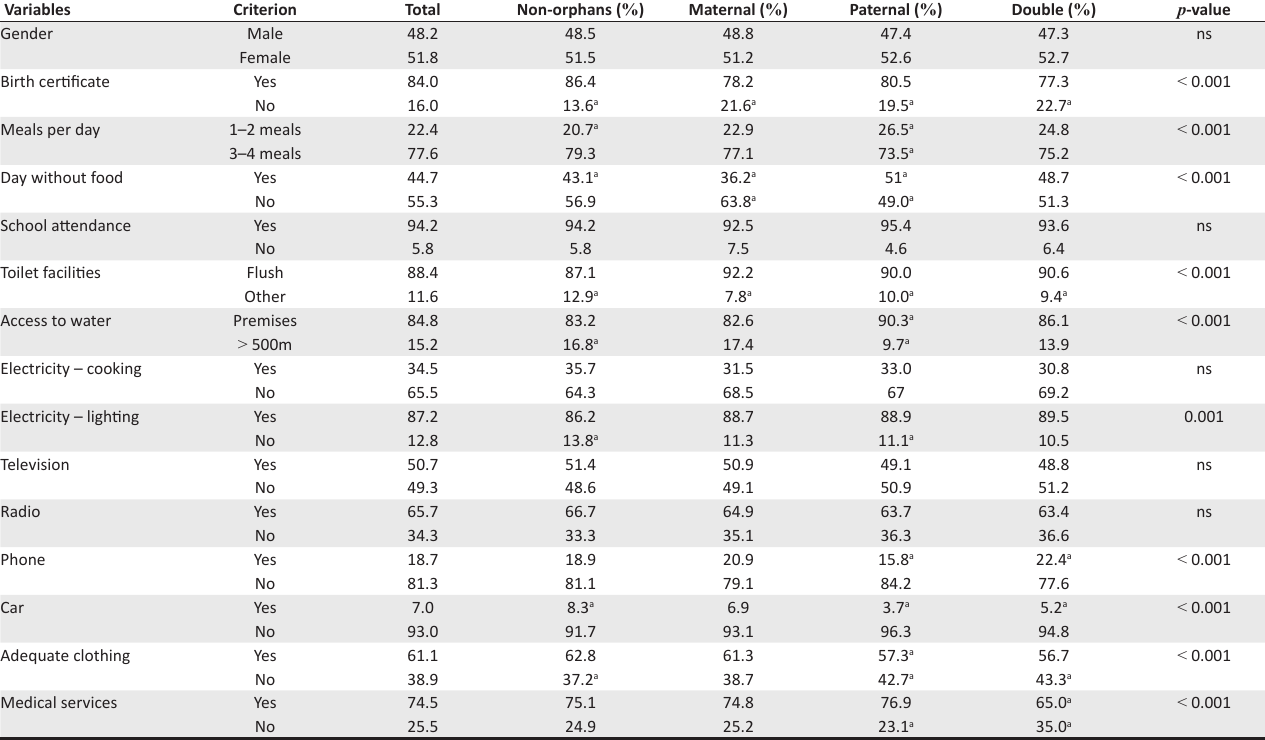
TABLE 4: Difference between non-orphans, maternal, paternal and double orphans on key criteria of vulnerability in